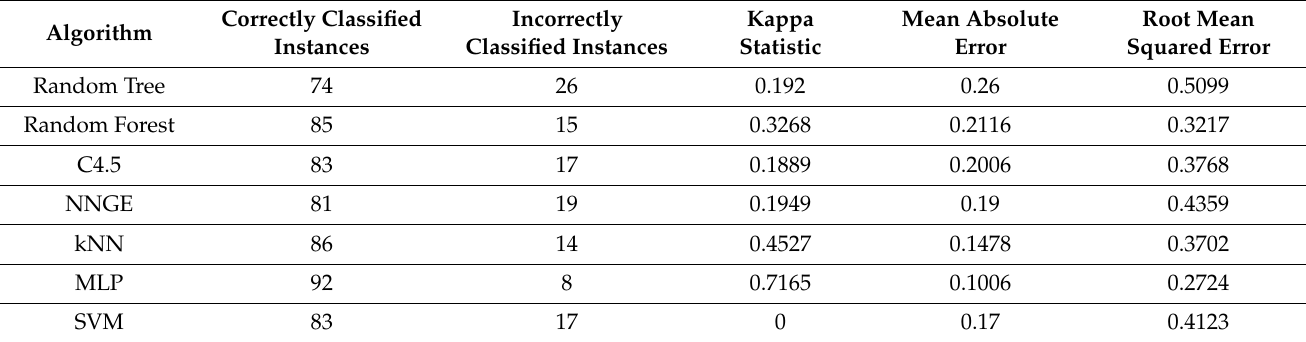
Table 9. Results obtained with different classification algorithms for assessing glaucoma